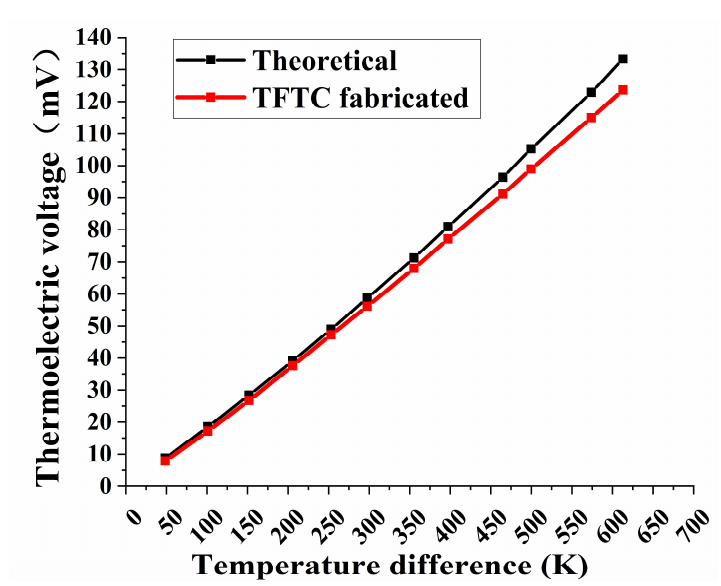
Figure 15. Static test thermoelectric voltage and theoretical curve of WRe26-In 2 O 3 TFTCs.